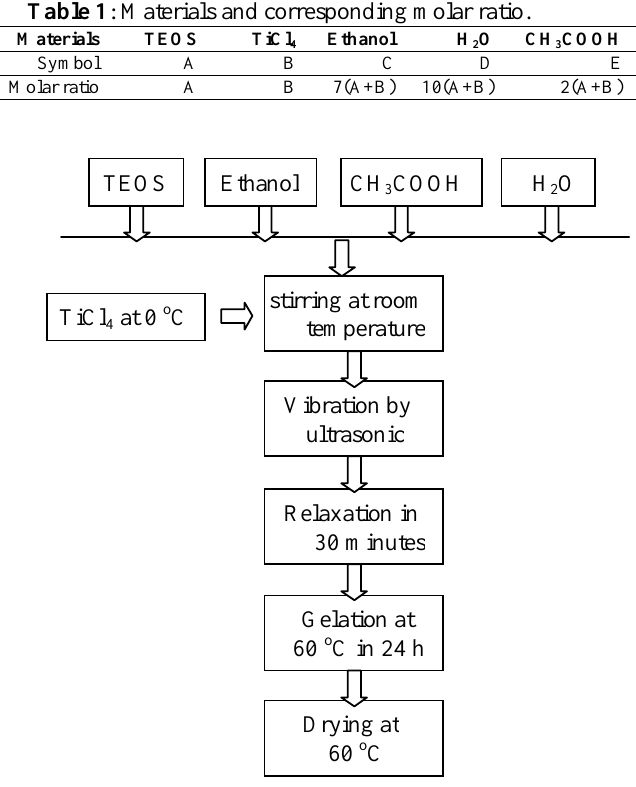
Fig. 1. The procedure for preparing TiO